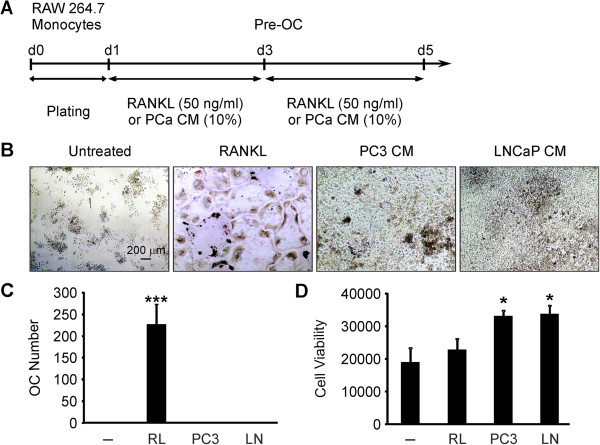
Soluble factors produced by prostate cancer cells do not induce osteoclast formation from naïve RAW 264.7 precursors but increase the cell viability. RAW 264.7 monocytic cells were cultured for 4 days untreated (negative control), treated with 50 ng/ml RANKL (RL, positive control), or supplemented with 10% serum free CM from PC3 or LNCaP, fixed, and stained for TRAP. A) Schematic overview of experimental setup for osteoclastogenesis assay from RAW 264.7 cells. B) Representative images of cultures after 4 days of treatment. C) Average osteoclast numbers formed in different cultures. Data are means ± SEM; n = 10 independent experiments; ***P < 0.001 indicates significance compared to untreated cells as assessed by Student’s t-test. D) RAW 264.7 cells were cultured for 2 days untreated, treated with 50 ng/ml RANKL, or supplemented with 10% PC3 or LNCaP CM. The cells were then incubated with AlamarBlue reagent for 20 h, and cell viability was assessed as the average fluorescence intensity of viable cells subtracted from the readings obtained from the medium. Data are means ± SEM; n = 5 experiments; *P < 0.05 indicate significance compared to negative control as assessed by Student’s t-test.